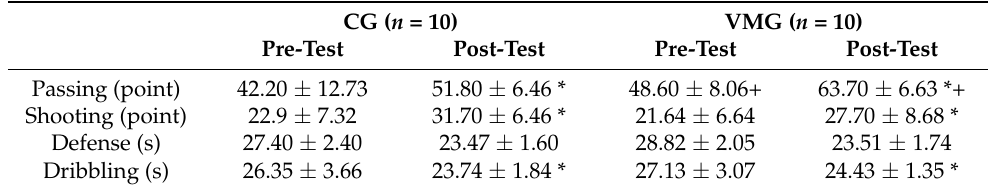
Table 4. Technical performances recorded in the basketball skill test for both video modeling (VMG) and control groups (CG) before and after the intervention period (Values are mean ± SD; n = 20). CG ( n = 10) VMG ( n = 10)